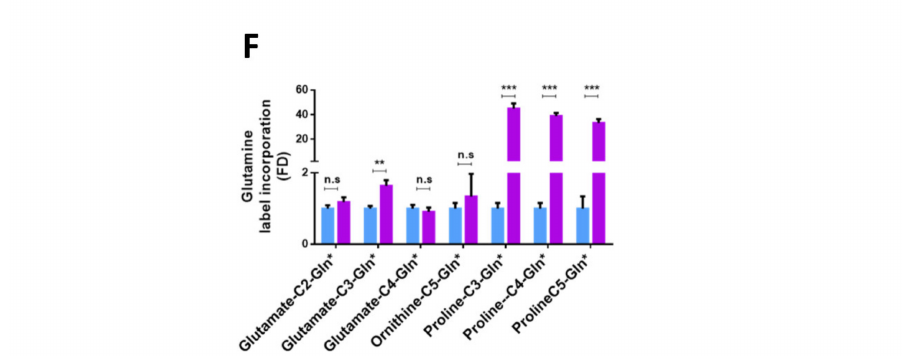
Figure 4. Imatinib resistance results in the rewiring of glutamine / glutamate metabolism to proline, collagen and glutathione metabolism. ( A ) Extracellular metabolic fluxes of KU812 Parental and imatinib resistant (ImaR) cells under normoxia (Norm) and hypoxia (Hyp). Data are mean ± SD for n = 3 of n = 2independentexperiments. Glutamineconsumptionandglutamateproductionwereobtainedunder normoxia. Data were normalized to cell number and incubation time. ( B ) Western blotting analysis of total protein fractions related to glutamine and proline metabolism of KU812 Parental and ImaR cells undernormoxiaorhypoxia. Dataaremean ± SDfor n = 3of n = 2independentexperiments. Kidney-type glutaminase 1 (KGA-GLS1), glutaminase C (GAC-GLS1), glutaminase 2 (GLS2), and glutamine synthetase (GS) ( C ) Protein profile of the rewiring of glutamine metabolism in KU812 imatinib-resistant when compared to KU812 parental cells (mean ± SD for n = 2 replicates). Log2 fold change values were calculated and represented by green color = protein upregulation; and red = protein downregulation. ( D ) Representative experiment of the amino acids consumption and production rates (mean ± SD for n = 3 replicates) significantly di ff erent between KU812 Parental and ImaR cells under normoxia and hypoxia. ( E )Intracellularconcentrationsofaminoacidssignificantlydi ff erentbetweeninKU812Parental and ImaR cells under normoxia. The data are mean ± SD for n = 3 replicates. ( F ) Fold di ff erence value (mean ± SD for n = 3 replicates) in 13 C Glutamine label incorporation in some metabolites of the KU812 ImaR cells compared to KU812 Parental cells in normoxia. Statistically significant di ff erences in all the panels was determined by two-tailed independent sample Welch’s t -test when n < 3 and Student’s t -tests when n > 3: * p < 0.05, ** p < 0.01, *** p < 0.001, and p ≥ 0.05 (n.s. = non-significant di ff